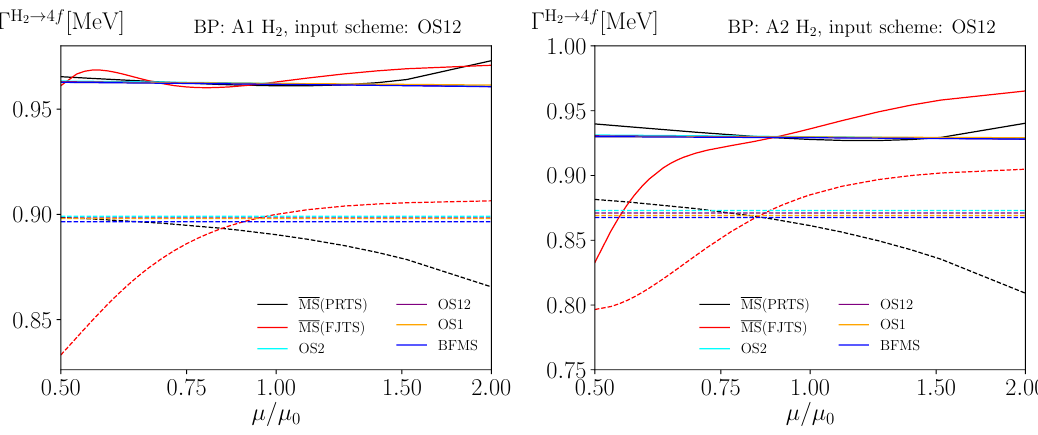
Figure 2 . Scale dependence of the decay widths (cid:0) H 2 ! 4 f of the light THDM Higgs boson H 2 for the THDM scenarios A1 (left) and A2 (right) in di(cid:11)erent renormalization schemes, with the OS12 scheme as input scheme (and full conversion of the input parameters into the other schemes). LO results are shown as dashed, NLO as full lines; the central scale is set to (cid:22) 0 = ( M H 2 M ) = H +